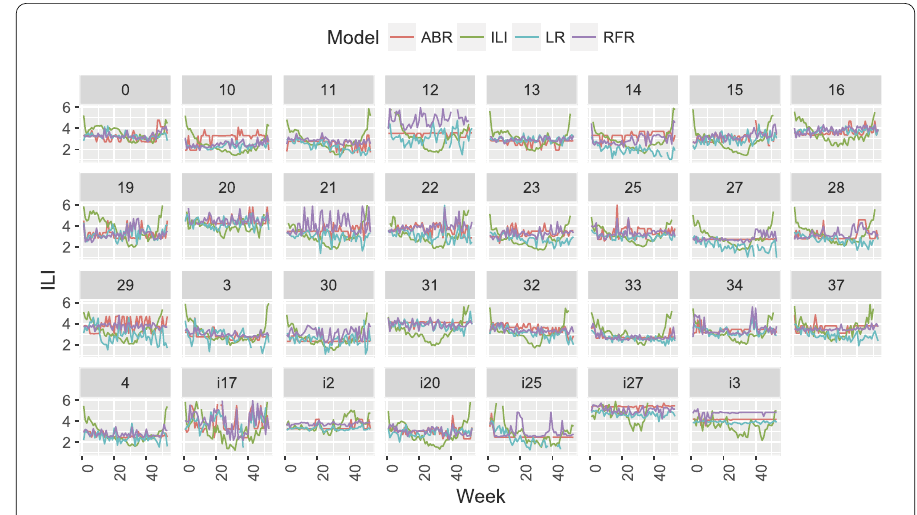
Figure 8 True vs. predicted %ILI (current week estimates) as a function of time for 31 geolocations. We plot true %ILI (ILI), predictions from sentiment and emotion features made using with AdaBoost (ABR), Linear (LR) and RandomForest (RFR)